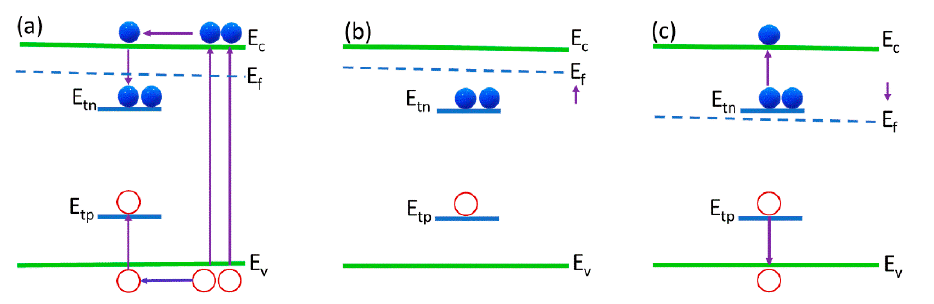
Figure 1. Band diagram of: ( a ) trap filling via optical injection of charge carriers; ( b ) after complete trapping; ( c ) under thermal release of carriers.